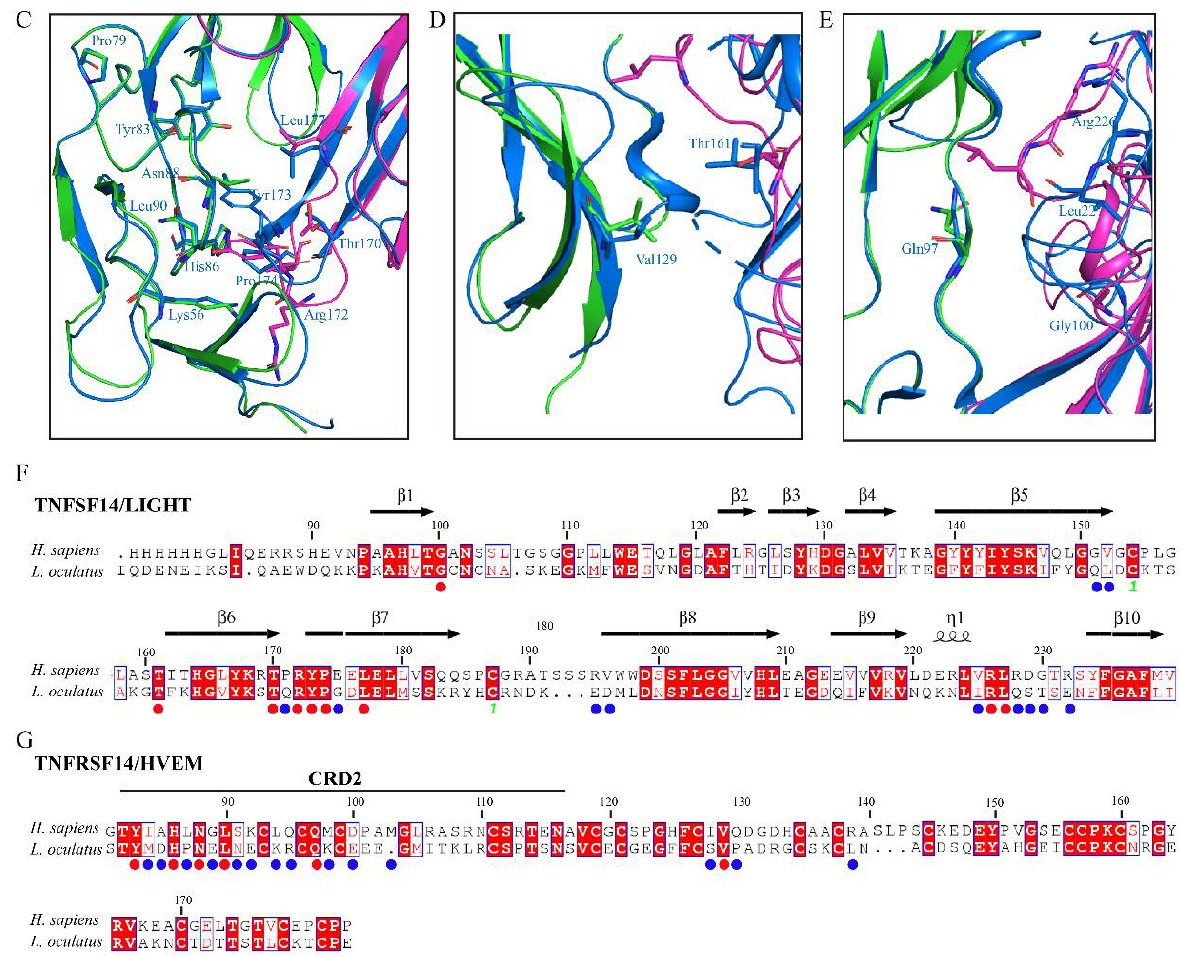
Figure 5. Structural modeling of the Spotted gar TNFSF14/TNFRSF14 complex. ( A ) the 3D structures of spotted gar TNFSF14/TNFRSF14. The structure is shown in cartoon and colored in magenta and green, respectively. ( B ) Superposition of the modeled structure with the hLIGHT/hHVEM (TNFSF14/TNFRSF14) complex. Black box indicates the key interaction area. ( C – E ) The conserved residues that participate in the interaction between hLIGHT and hHVEM and the corresponding residues in spotted gar TNFSF14-TNFRSF14 were also shown. ( F , G ) Structure-based amino acid sequence alignment of TNFSF14 and TNFRSF14. Black arrows and cylinders above the alignment indicate β -strands and α -helices. The residues involved in the interaction between ligand and receptor are indicated by red (identical) and blue (not identical)